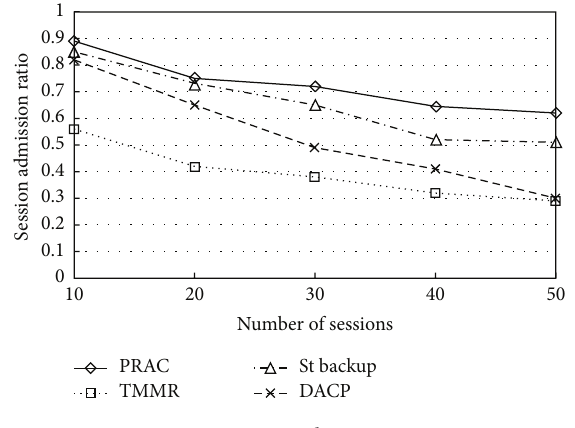
Figure 8: Session admission ratio.